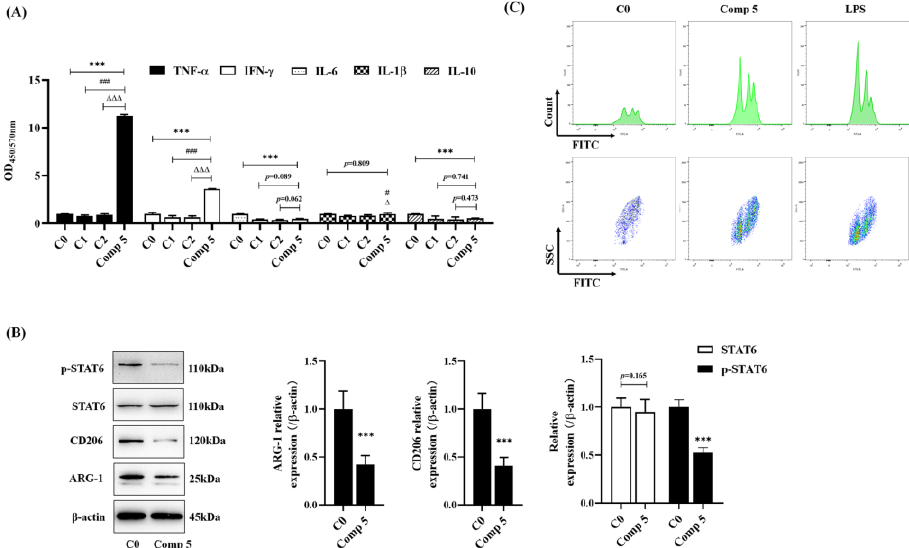
Figure 7. The effects of Compound 5 on HepG2 cells or HepG2 and RAW264.7 co-cultivation. C0: HepG2 and RAW264.5 co-cultivations. C1; RAW264.7 cells; C2; RAW264.7 cells were treated with 25